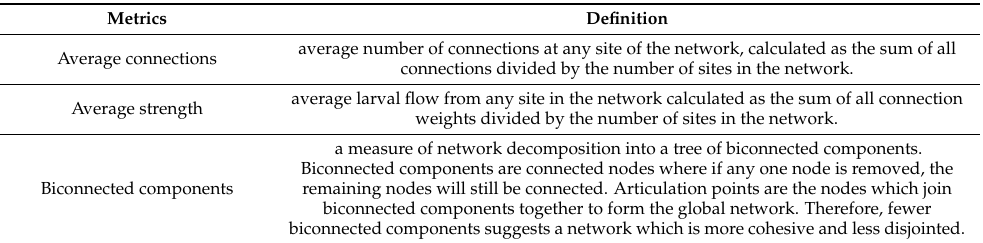
Table 1. Descriptive metrics of global network